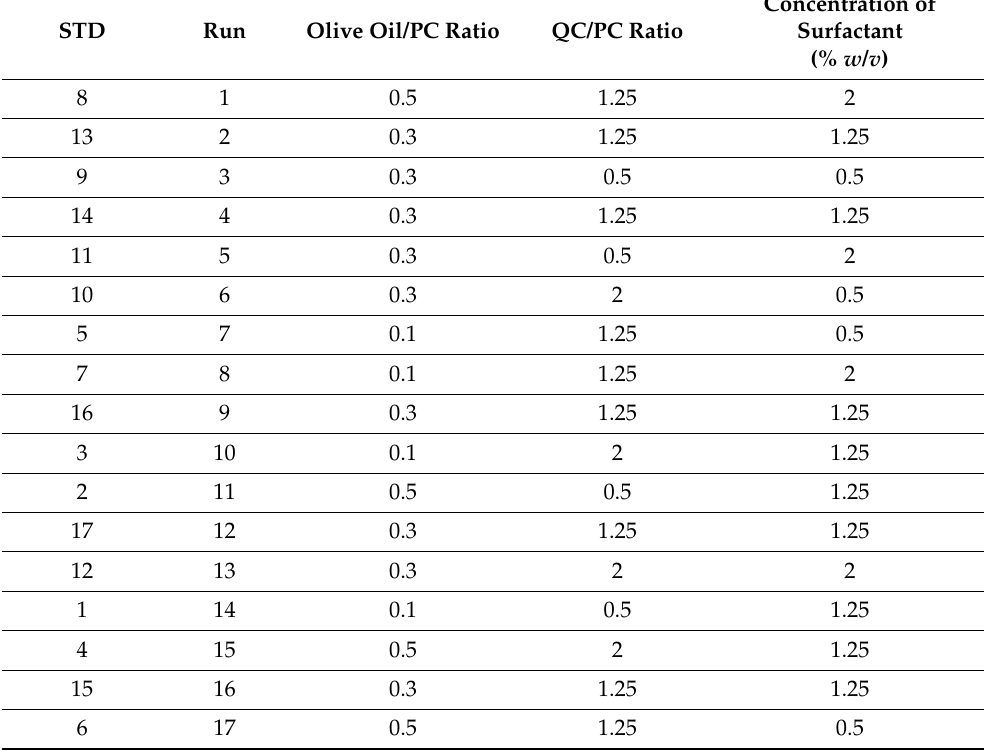
Table 2. Compositions of different formulations according to Box–Behnken